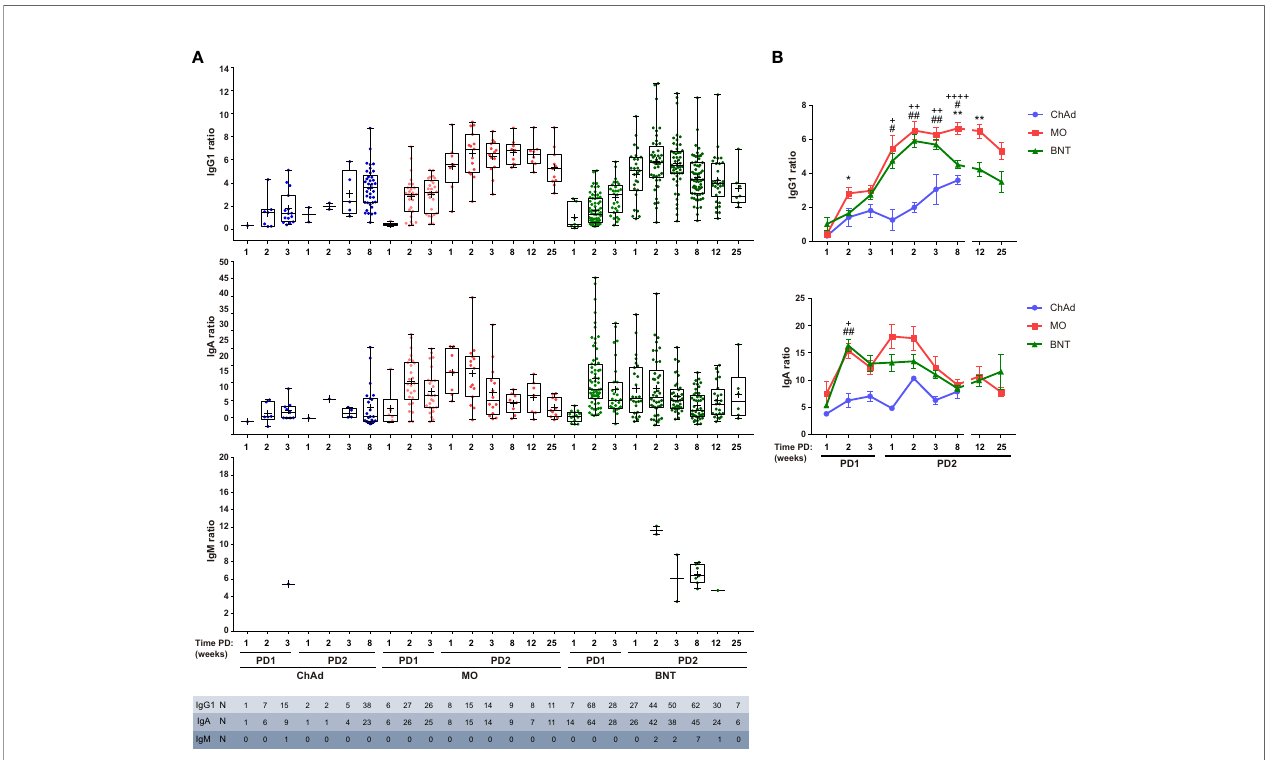
FIGURE 3 | Ig anti-Spike titer follow-up after vaccination. (A) IgG1, IgA and IgM titers of seropositive samples described in Figure 2 , expressed as Ig to GFP ratio. Median, line inside boxes; mean, +; bars, min and max values. (B) Overlay representation of data showed in (A) Mean and SEM indicated. Two- way ANOVA was used to compare data series starting 1 week PD1 and ending 8 weeks PD2 (IgG1, p < 0.0001 for both time PD and vaccine type variables) (IgA, p ≤ 0.01 for vaccine type variable). Multiple comparisons for matched time PD, are depicted in the graphs: +, ChAd vs MO; #, ChAd vs BNT; *, MO vs BNT. The number of symbols indicates the p value summary: no symbol, no signi fi cance; +, #, *, p<0.05; ++, ##, ** p ≤ 0.01; ++++ p<0.0001. Two-way ANOVA with Sidak ’ s